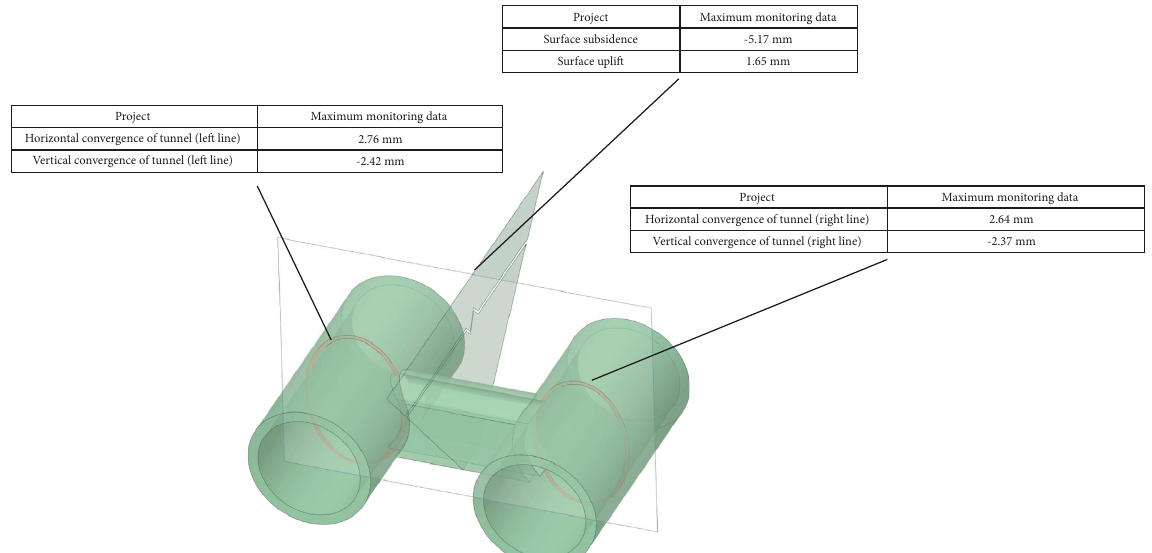
Figure 6: Tunnel crown settlement and surface and pipeline